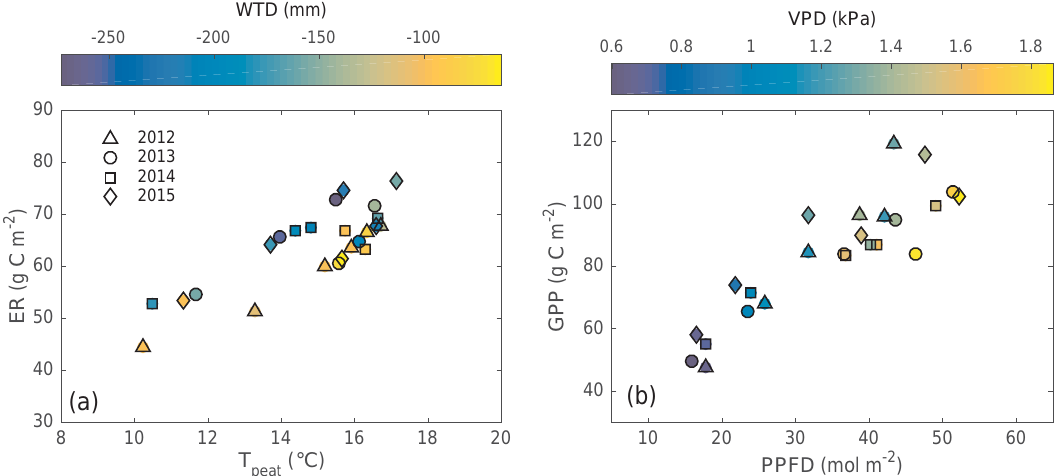
Figure 7. Monthly means of summertime (December–February) and autumn (March–May) (a) ecosystem respiration (ER) versus peat temperature ( T peat ) with symbol fill color according to water table depth (WTD), and (b) gross primary production (GPP) versus integrated photosynthetic photon flux density (PPFD) with fill color according to daily maximum vapor pressure deficit (VPD) over the 4 measurement years.